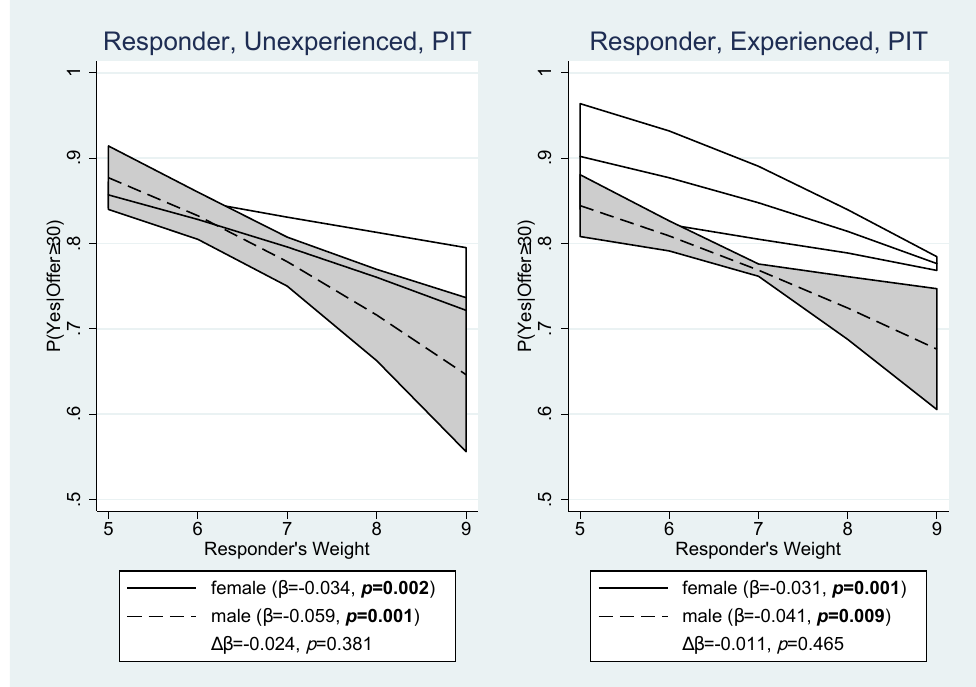
Figure 6. Responder Voting Behavior in P IT : Proposer’s Offer ≥ 30. The graphs show the responder’s average probability to vote “yes” on an offer ≥ 30 tokens by experience, gender, and nominal weight. β and ∆ β are the marginal effect of the nominal voting weight and the differential slope of Gender { 1 = male } estimated by a random effects panel probit regression; p is the significance level; shaded areas represent 90% confidence intervals around the